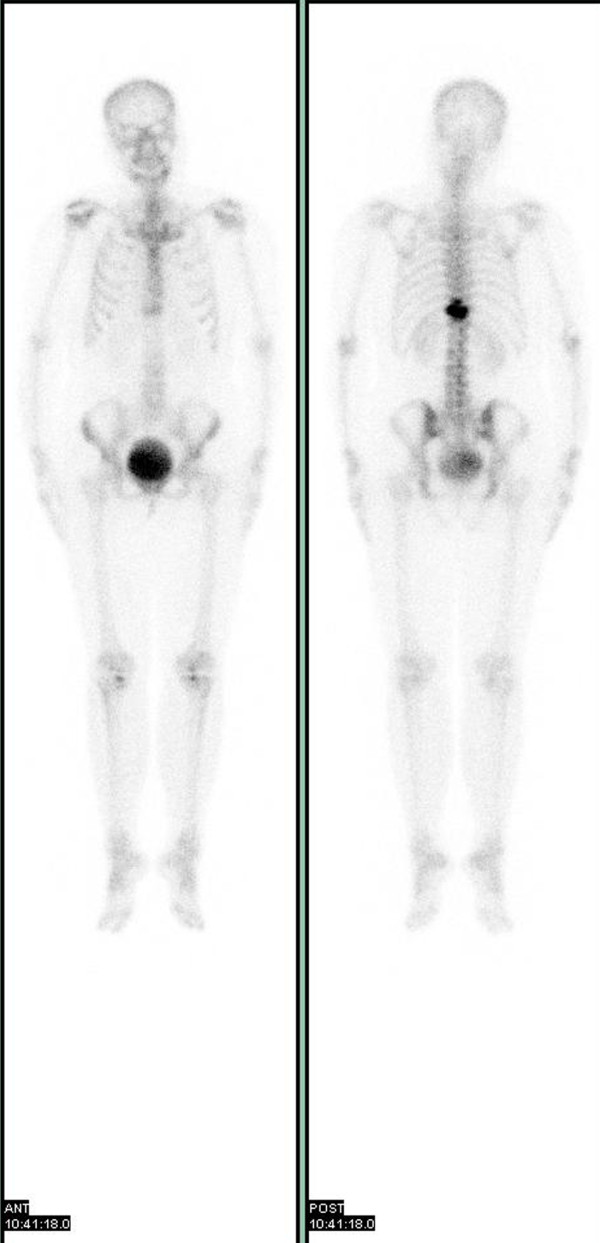
The image of 99Tcm-methylene diphosphonate (MDP) bone scintigraphy after left radical mastectomy. The bone scan showed radioactive concentration in the tenth and eleventh thoracic vertebrae, indicating the appearance of bone metastasis at these sites.